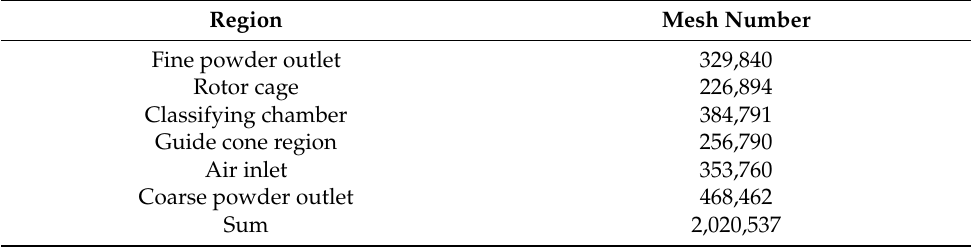
Table 2. Mesh number in each region of the high-efficiency rotor